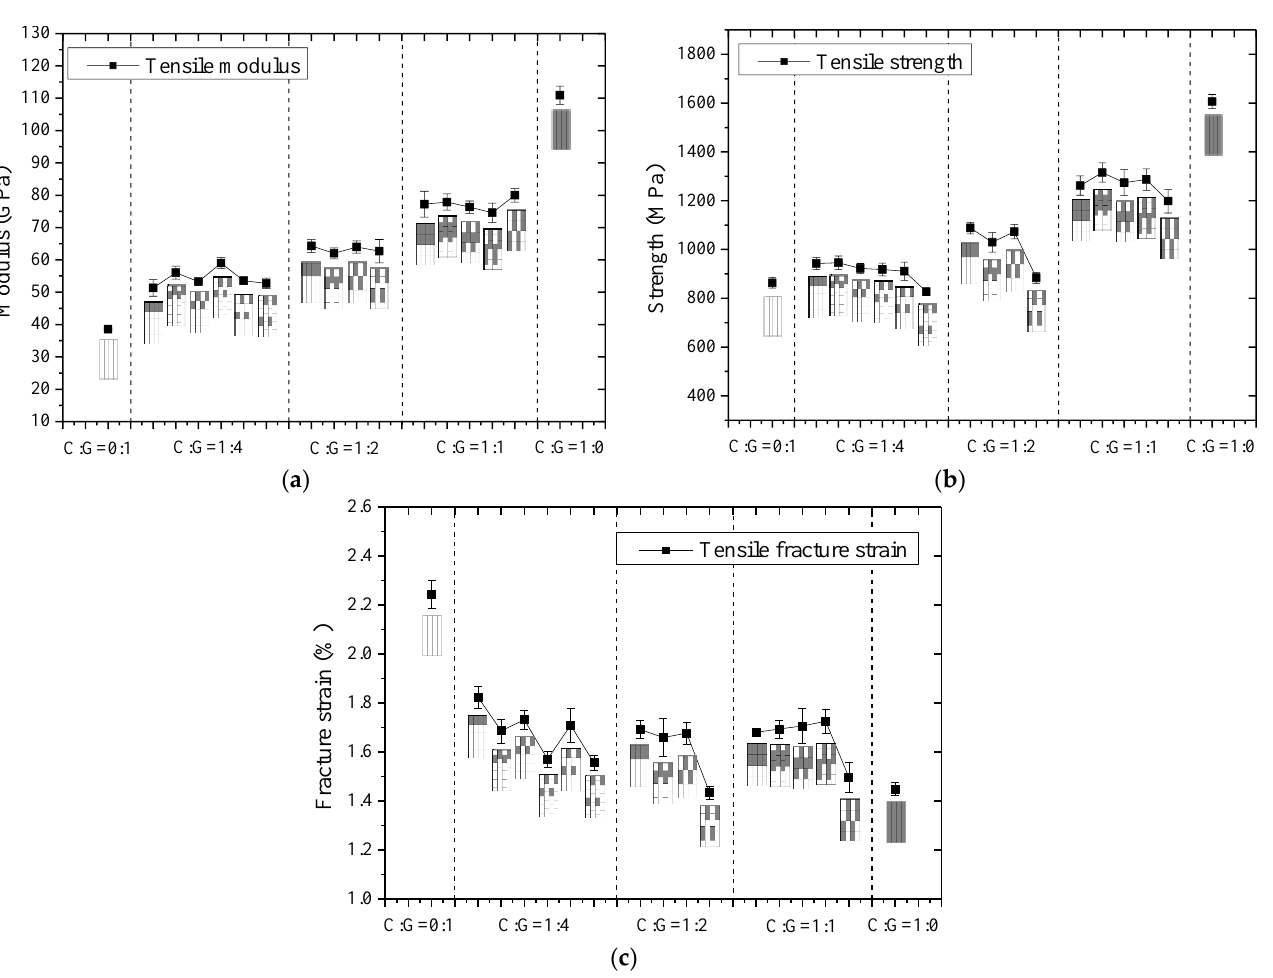
Figure 19. Tensile properties of intralayer hybrid composites with various hybrid ratios and stacking structures: ( a ) tensile modulus; ( b ) tensile strength; ( c ) fracture strain.